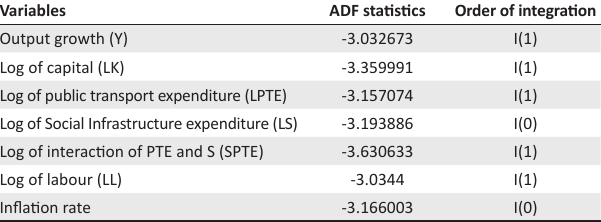
TABLE 8: Augmented Dickey–Fuller unit root test for Buffalo metro.